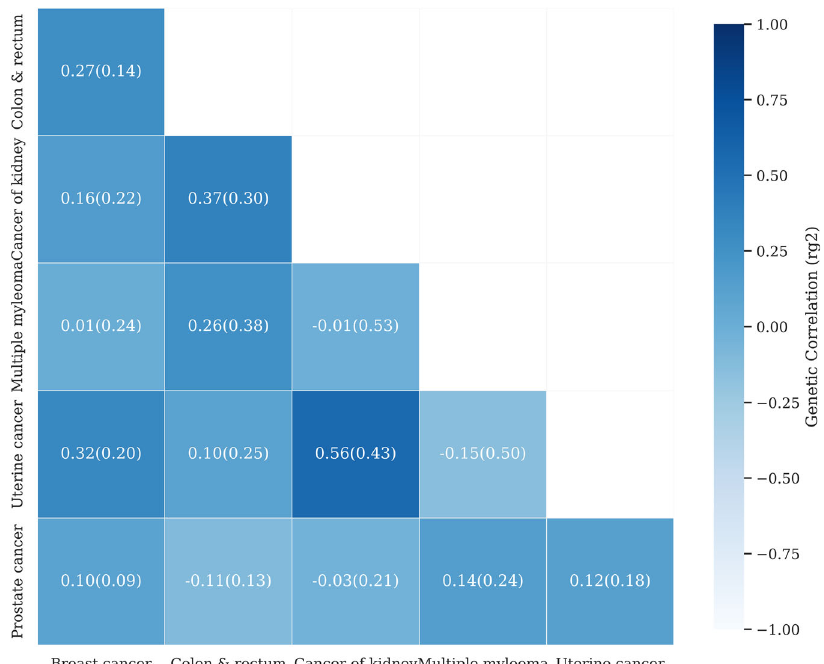
Fig. 5 Estimation of pair-wise genetic correlation among obesity-related cancers in which breast, prostate and uterine cancers are hormone-sensitive cancers. The positive genetic correlations are colorectal cancer with cancer of the kidney, women breast cancer with uterine cancer. The negative genetic correlation includes prostate cancer with colorectal cancer, uterine cancer with multiple myeloma. The estimates with the standard error (r g ± se) are obtained applying the bivariate LDSC method. Ovarian and thyroid cancers were not estimable, which was probably due to the fact that the number of cases was not suf fi cient for LDSC in the analysis of these